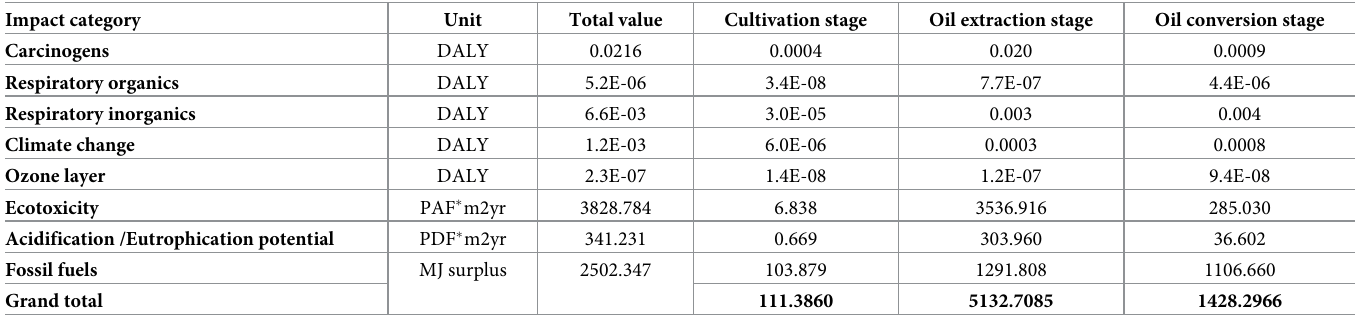
Table 2. Environmental impacts of the three stages of biodiesel production from JC seeds